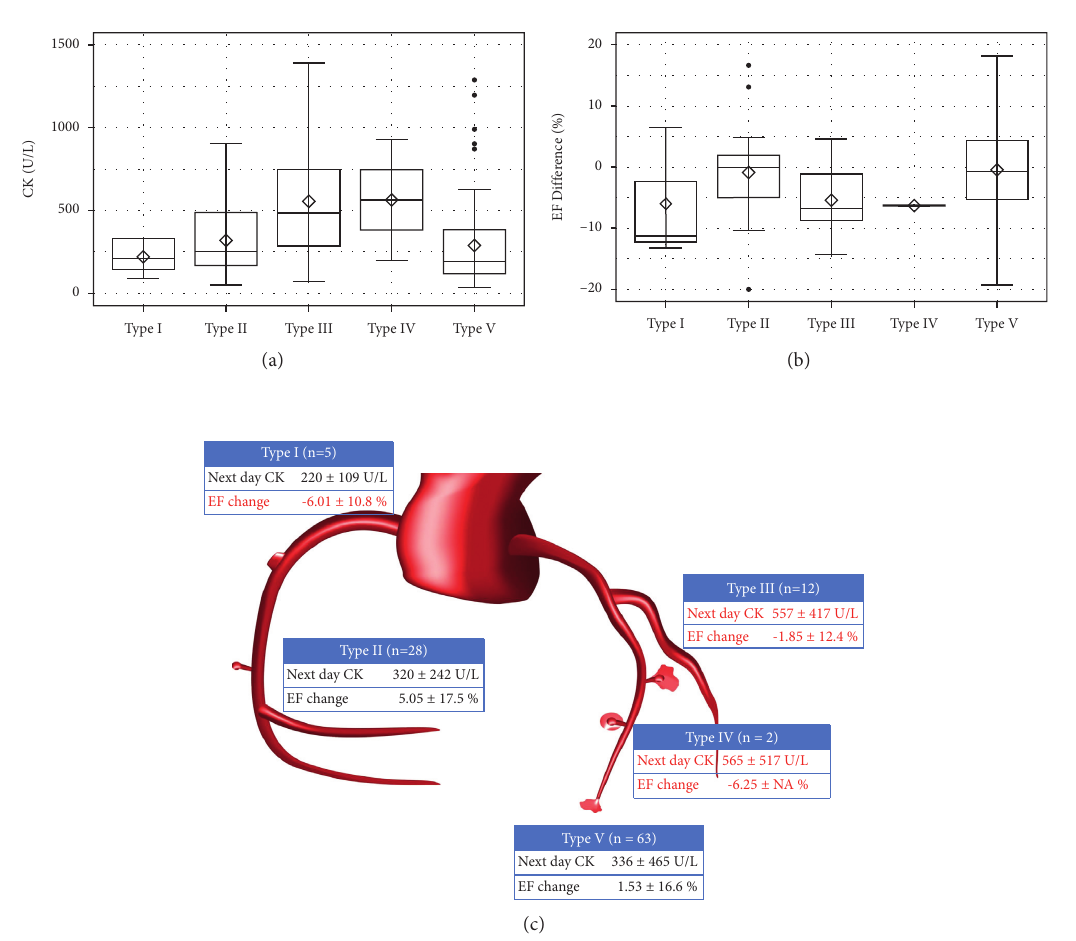
Figure 2: Box and whisker plot of creatinine kinase (CK) on the day after coil embolization (a), change in the ejection fraction (EF) from the baseline to follow-up (b), and schema (c) according to perforation